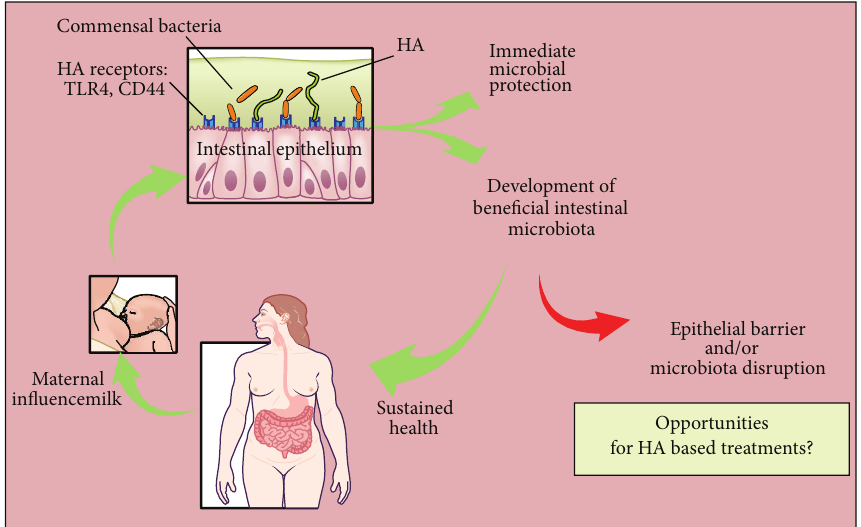
Figure 3: HA in milk may strengthen epithelial defense in the infant gut and foster development of a beneficial microbiota as the baby matures. Appropriate microbial colonization of the intestine is thought to contribute to sustained health into